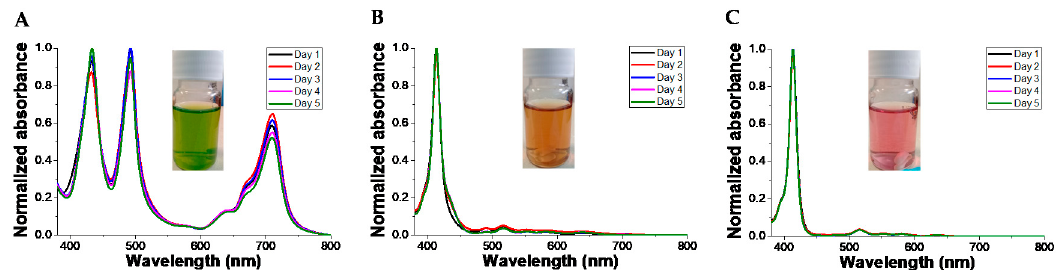
Figure 8. Normalized UV–vis spectra of TPPS at a concentration of 5 × 10 ⁻ 5 M and different pH in the presence of PKHEDA 1 × 10 ⁻ 4 M. pHs: ( A ) 2.92, ( B ) 6.29, ( C ) 10.70.